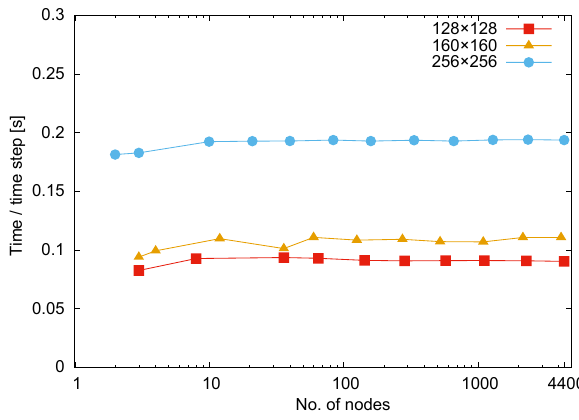
Figure 5. Weak scalability on the hybrid P100 Piz Daint nodes, per COSMO time step of the dry